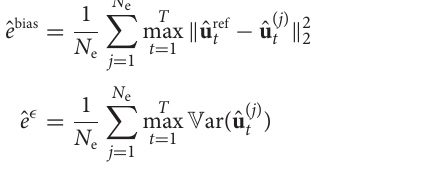
e bias t , and e ǫ t (Equation 24) for the estimation of E [ u t ] (water saturation field at 6 FIGURE 5 | Test case 1: Plot of ˆ ˆ e bias t and e ǫ t are shown as a function of computational budget p [1,2,3,4,5] 10 2 , where p is the number of MC realizations N that uses only high-fidelity model. ˆ ˆ = × e bias t at time t e ǫ t at time t (Left) 0.3 PVI. (Right) 0.3 ˆ ˆ = =